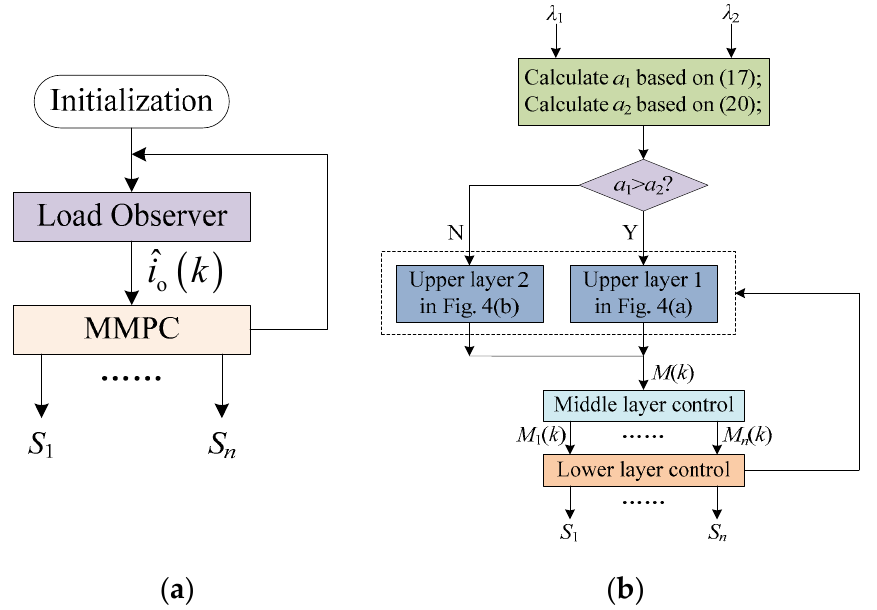
Figure 2. Structure diagram of the load observer based MMPC. ( a ) Structure of the overall control. ( b ) Structure of the proposed MMPC.